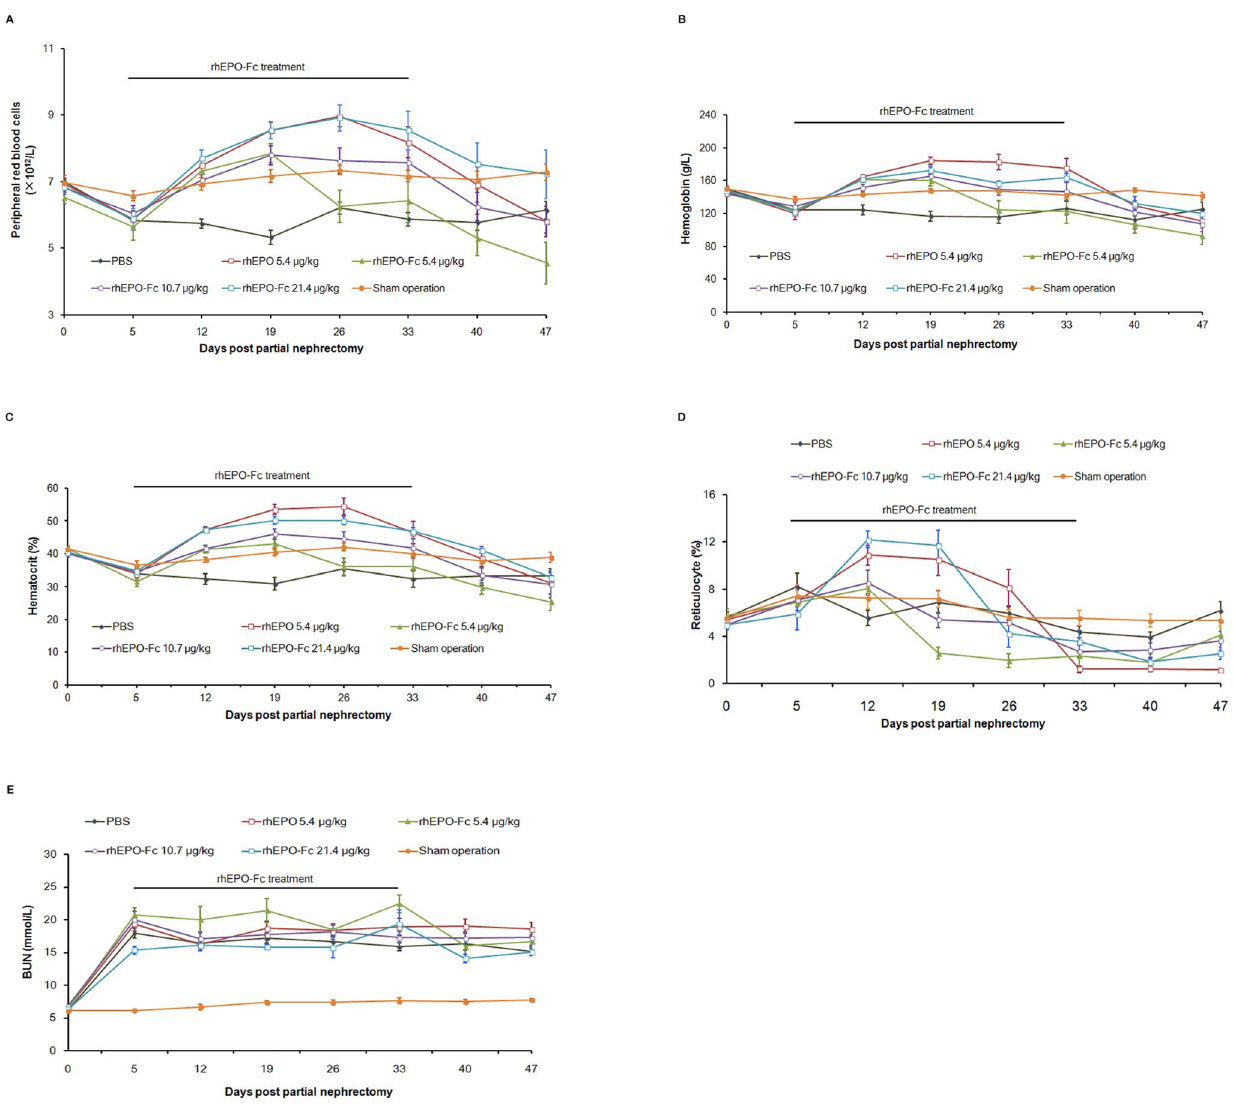
Figure 3. rhEPO-Fc attenuated anemia induced by partial renal ablation in rats. Blood samples were collected at the indicated time points (0–4 week, and additional two weeks after the treatment ended). RBC (Fig. 3A), hemoglobin (Fig. 3B), hematocrit (Fig. 3C), reticulocyte (Fig. 3D) and BUN (Fig. 3E) were shown. Data were presented as Mean 6 SD.